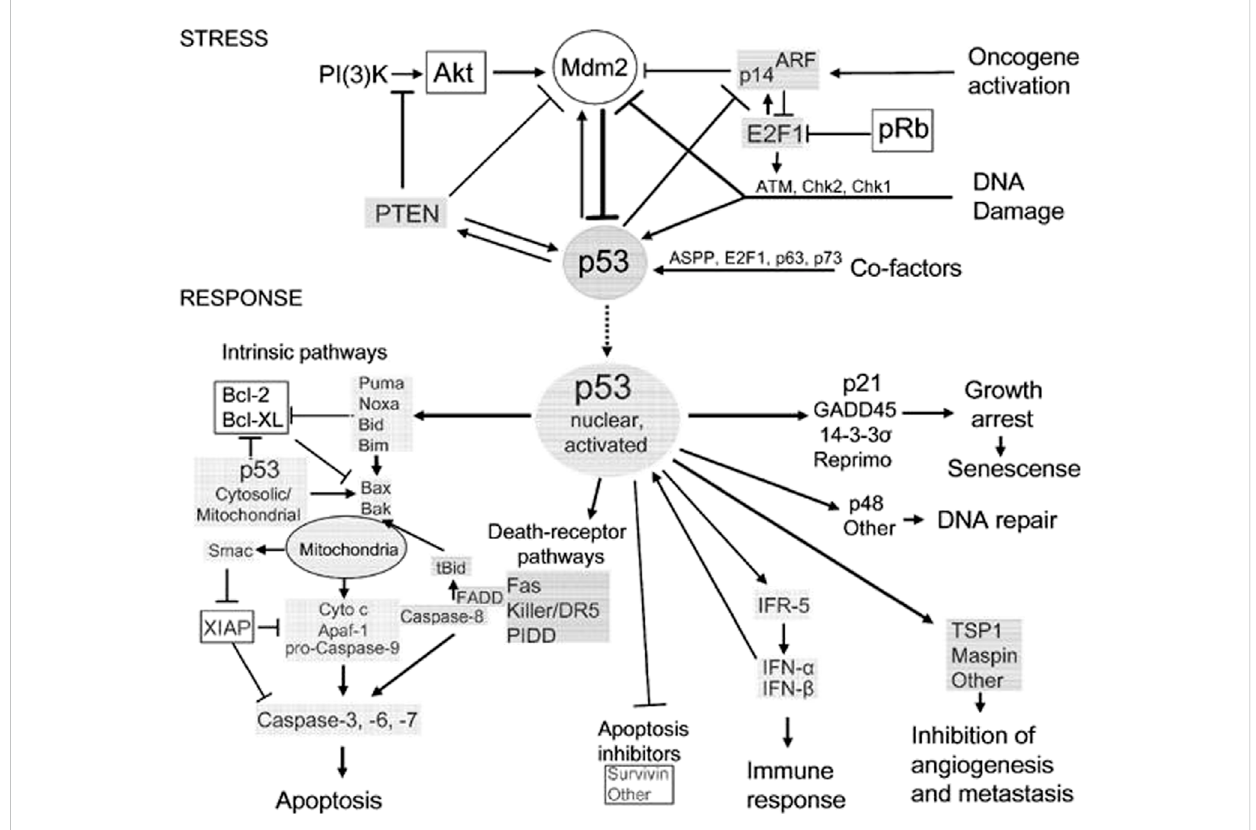
FIGURE 6 A schematic representation of p53 ’ s role in modulation of typical ferroptosis in osteosarcoma. The resulting effects of the biological processes are based on molecular responses to stress. Nuclear activation related to p53 protein are generated from the stress induced by tumorigenesis.